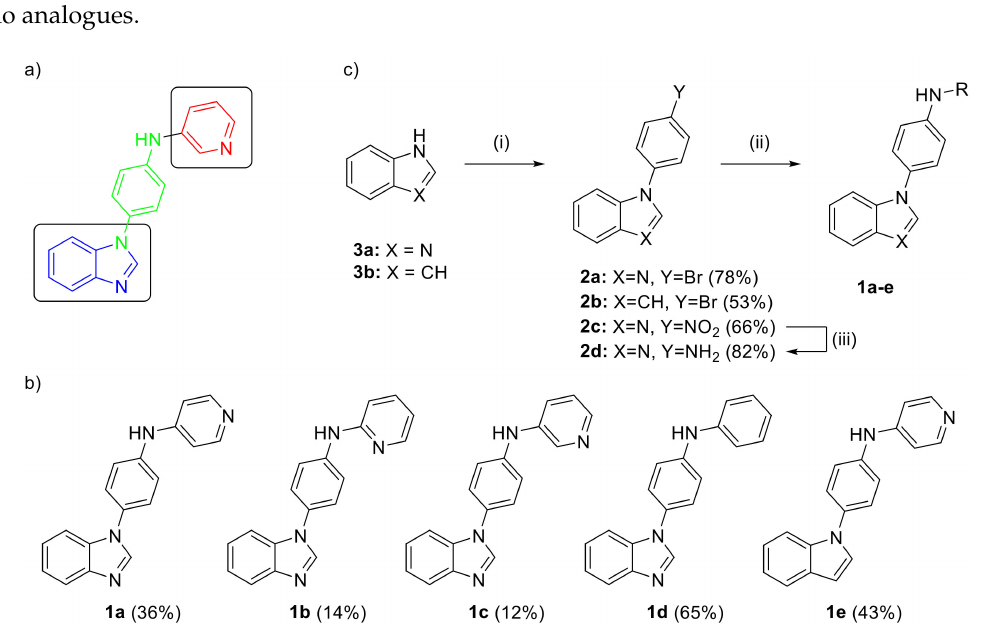
Figure 2. Compounds in the present study ( a ) highlighting the pyridine and benzimidazole moieties connected with the aniline linker ( b ) full structures and isolated yields ( c ) synthesis scheme with reagents andconditions: (i)1-bromo-4-fluorobenzeneor1-fluoro-4-nitrobenzene, K 3 PO 4 , DMF,150 ◦ C,(ii) t BuXPhos Pd G1 / G3, t BuXPhos, amine or 3-bromopyridine, t BuONa, t BuOH, RT to 70 ◦ C, (iii) 10% Pd / C, MeOH,